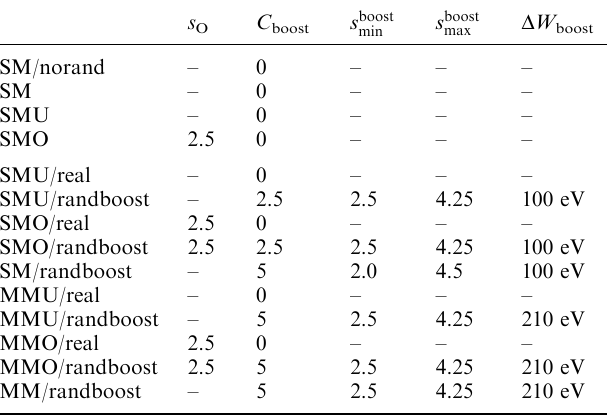
s C s boost s boost D W O boost boost max min